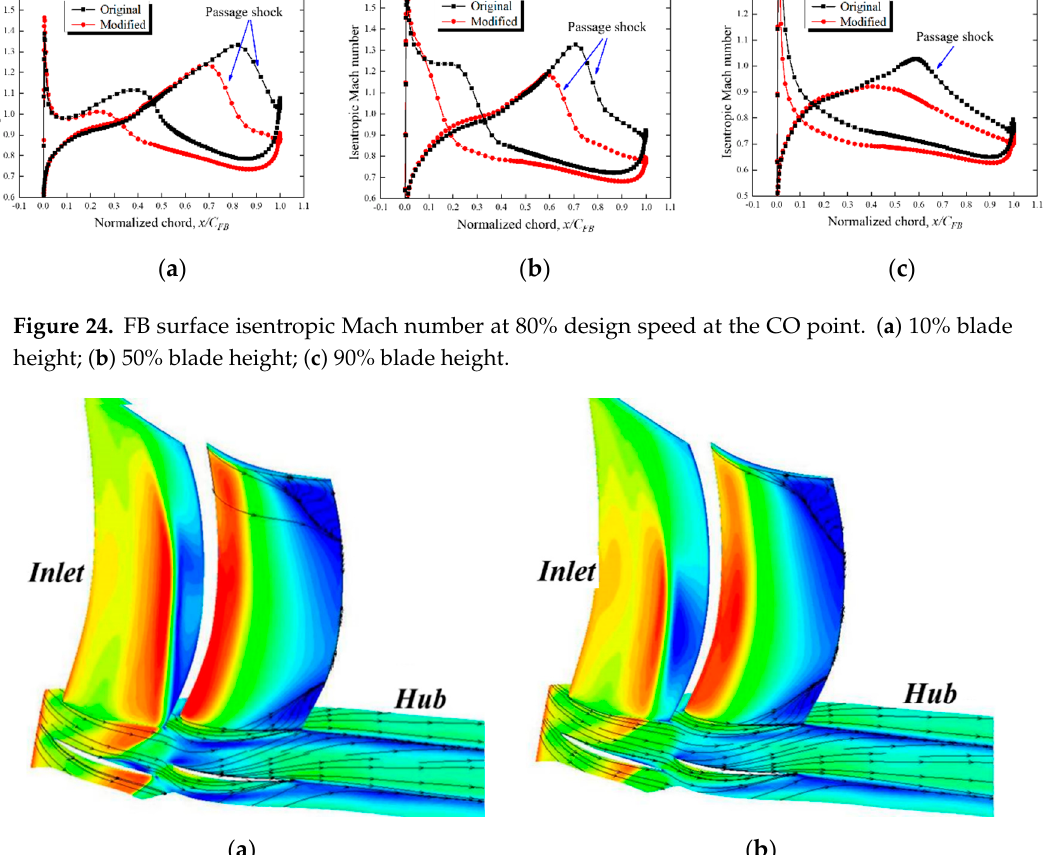
Figure 25. Mach contours near the blade surface at 80% design speed at the CO point. ( a ) Original; ( b ) modified.